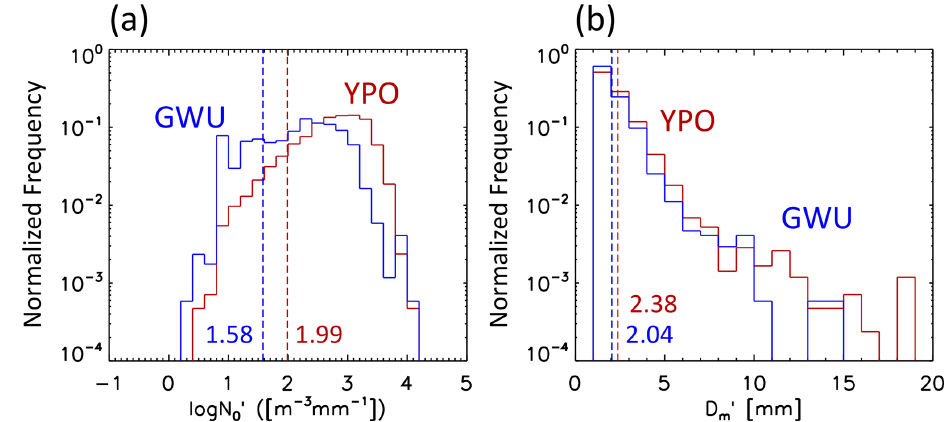
Figure 5. Normalized frequency of (a) log N (cid:48) each site.